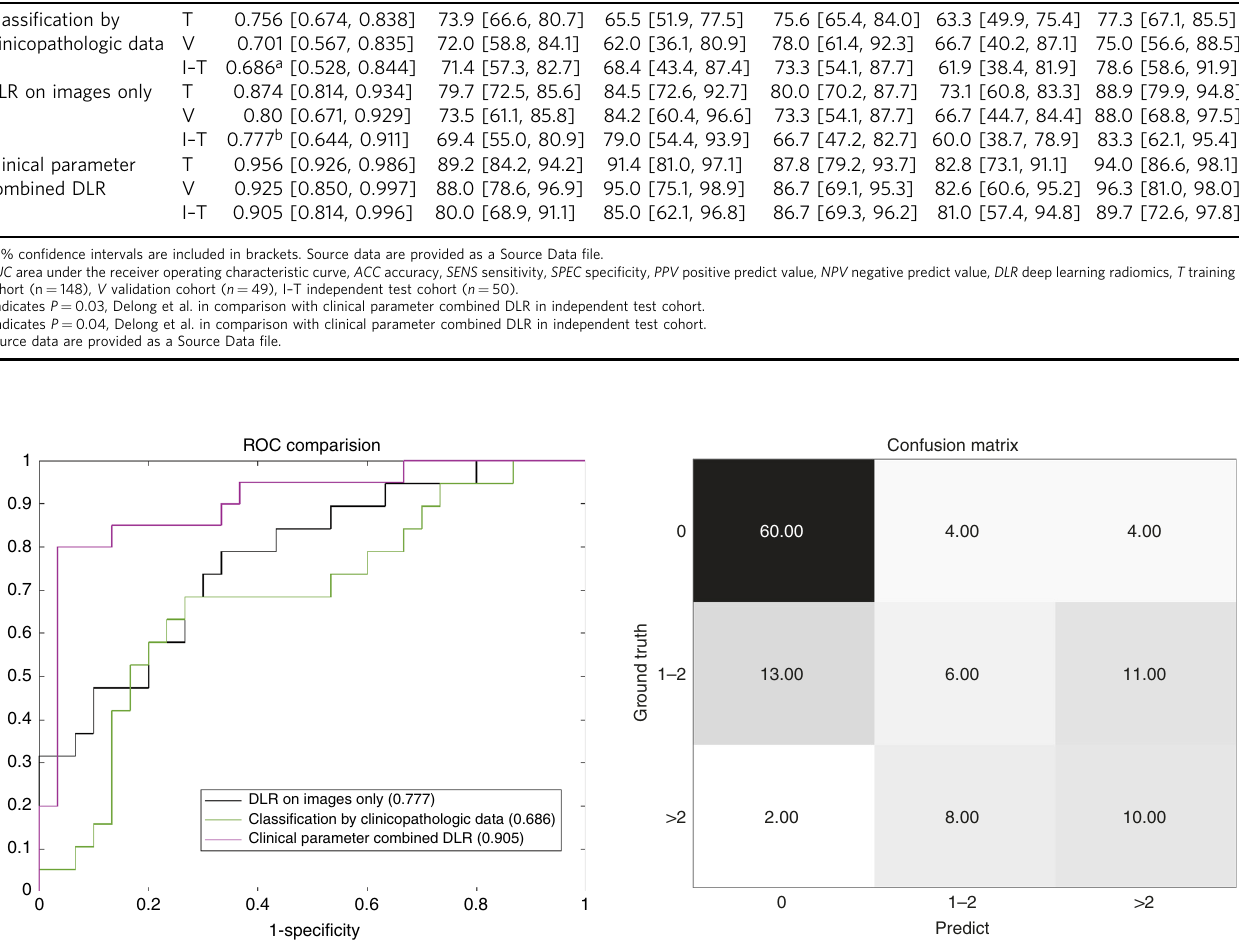
Table 4 The prediction of ALN status results (N + (1 – 2) v.s. N + ( ≥ 3)). Methods